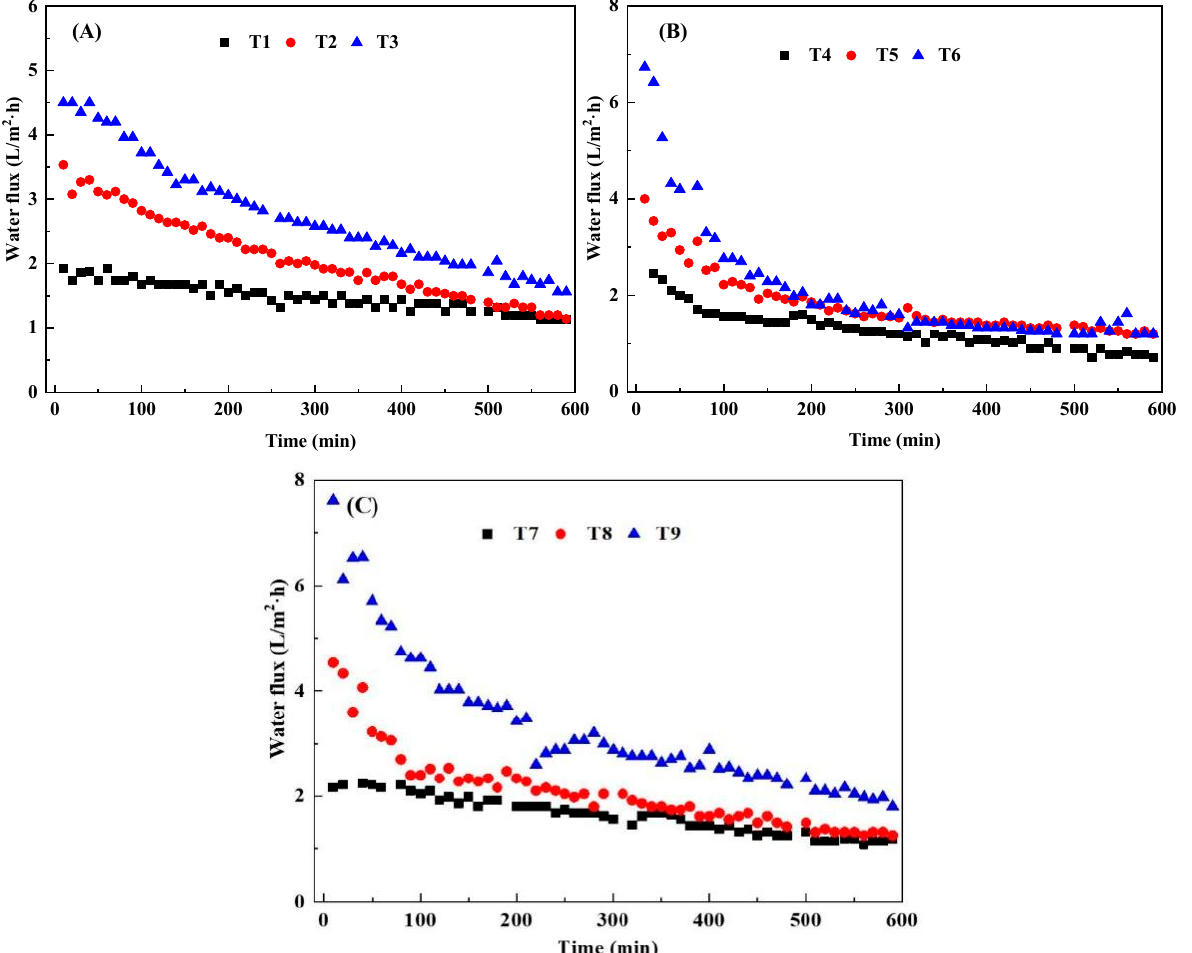
Figure 4. Change in water flux in orthogonal experiment of biogas slurry FO membrane concentration (T1, T2, T3) ( A ), (T4, T5, T6) ( B ), (T7, T8, T9) ( C ).